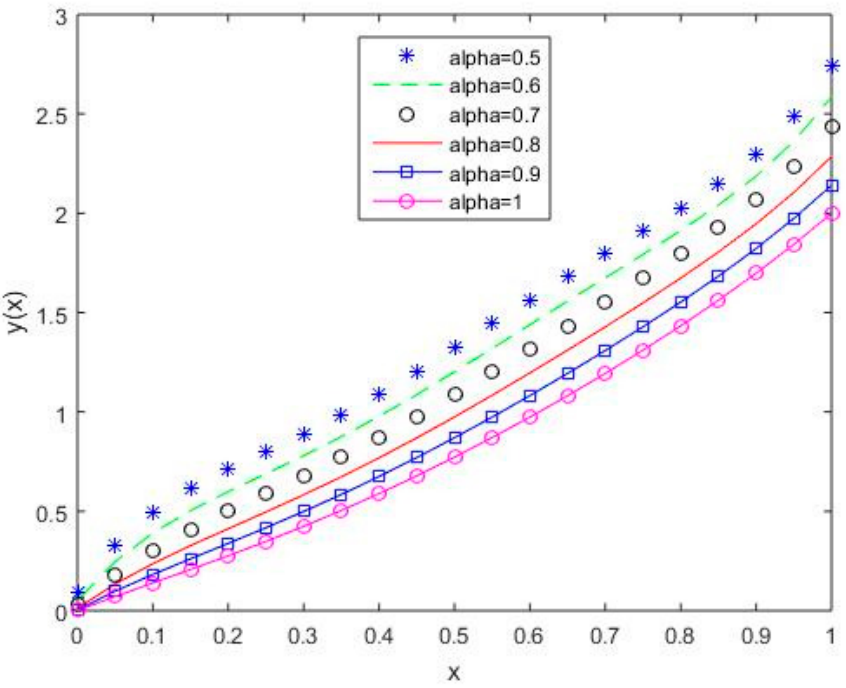
Figure 19. The behavior of solutions using S4 for α values of 0.5, 0.6, 0.7, 0.8, 0.9, and 1, Example 2.